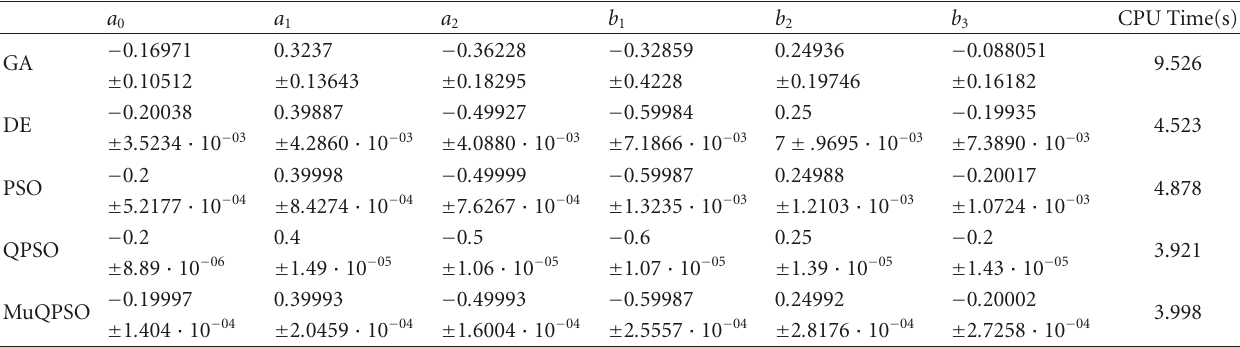
Table 6: Mean values and standard deviations of the filter coe ffi cients in Example 3 (mean of 100 random runs with randomly chosen initial